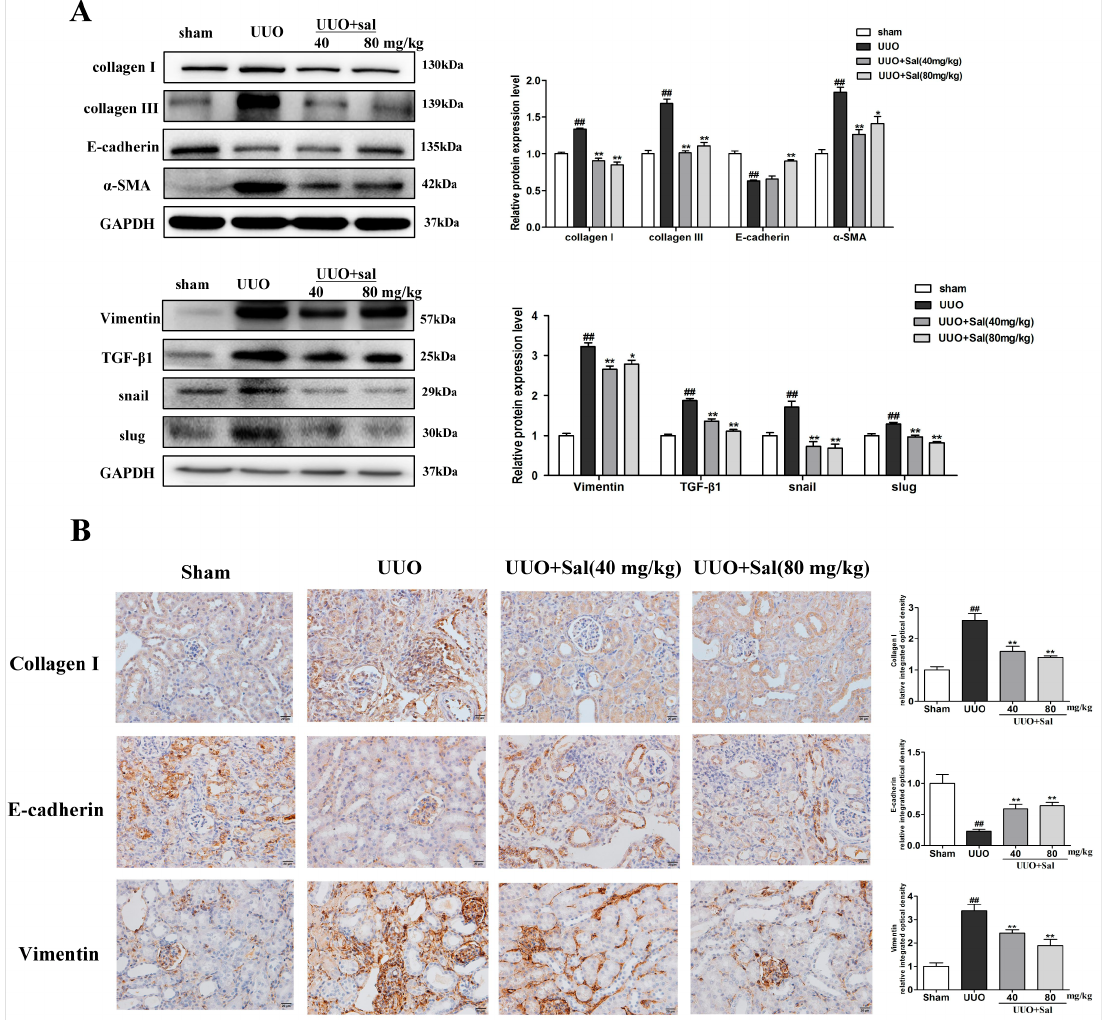
Figure 2. Sal reduced the accumulation of extracellular matrix components and blocked EMT in UUO mice. ( A ) Western blotting was performed to determine the protein expression of collagen I, collagen III, α -SMA, vimentin, E-cadherin, TGF- β 1, snail, and slug in the kidney tissue of UUO mice ( n = 3). ( B ) Immunochemical staining of collagen I, E-cadherin, and vimentin in the kidney tissue of UUO mice ( n = 3). Original magnification: × 400. All data are represented as mean ± SD. # P < 0.05, ## P < 0.01 vs. Sham group, * P < 0.05, ** P < 0.01 vs. UUO